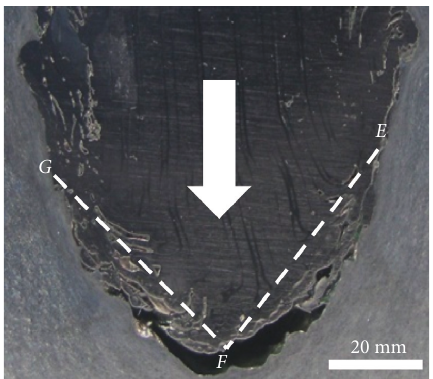
Figure 10: Photo of the residual high-density WF/Zr-MG com- posite penetrator nose. Figure 11: Zooming photos of the positions of E-F and G-F